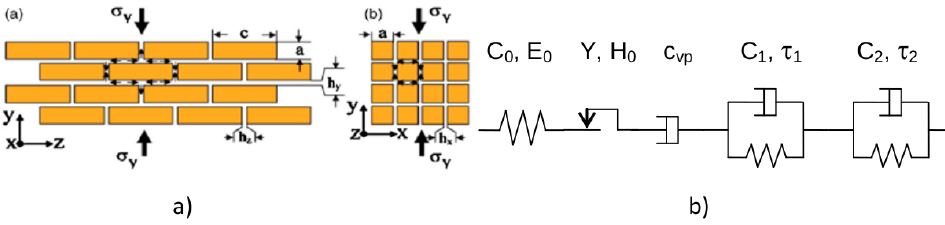
Figure 7. Schematic illustrations of creep behaviour mechanisms for of enamel a) and b) Viscous fluid squeezed between rigid apatitie crystals [58] and c) Viscoelastic-plastic body "spring + plastic element + dashpot + 2 Kelvin-Voigt bodies" [55].